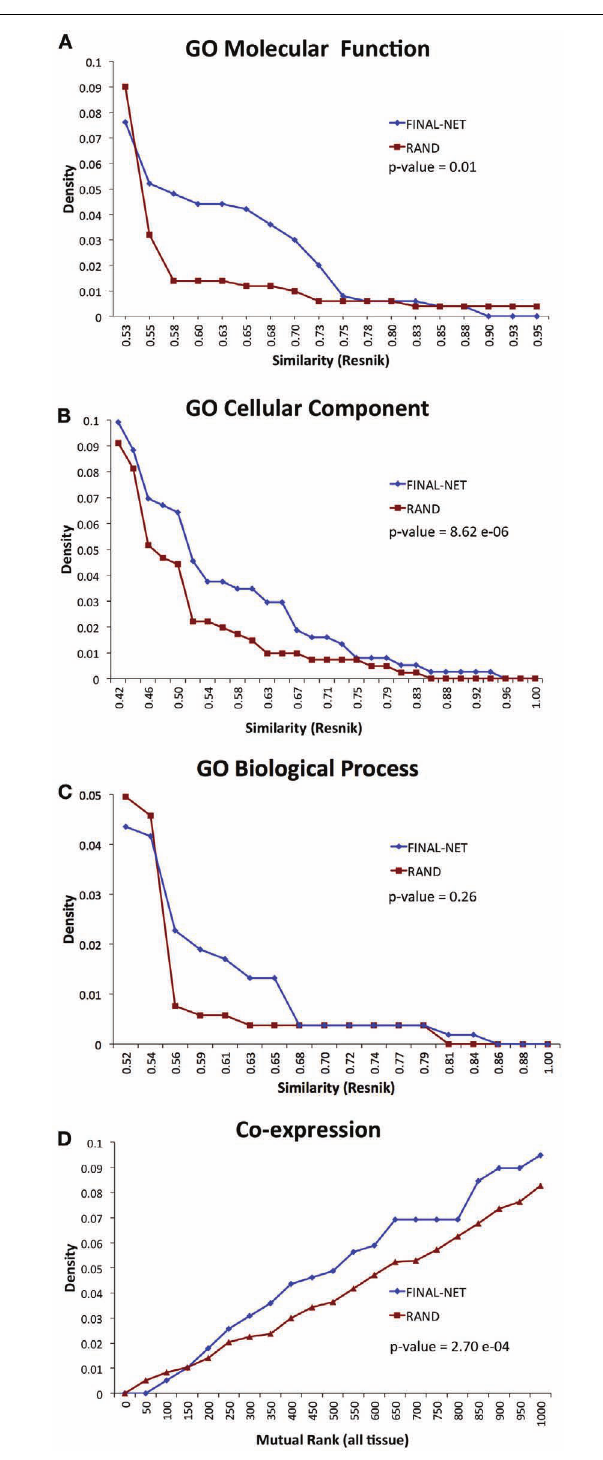
FIGURE 3 | Functional similarity distribution of interaction pairs in our final network compared to an average of 100 randomized networks with the Resnik method (Resnik, 1995) by using GO molecular function annotations (A), GO cellular component annotations (B), GO biological process annotations (C), and gene co-expression from ATTED II (Obayashi et al., 2009) (D).